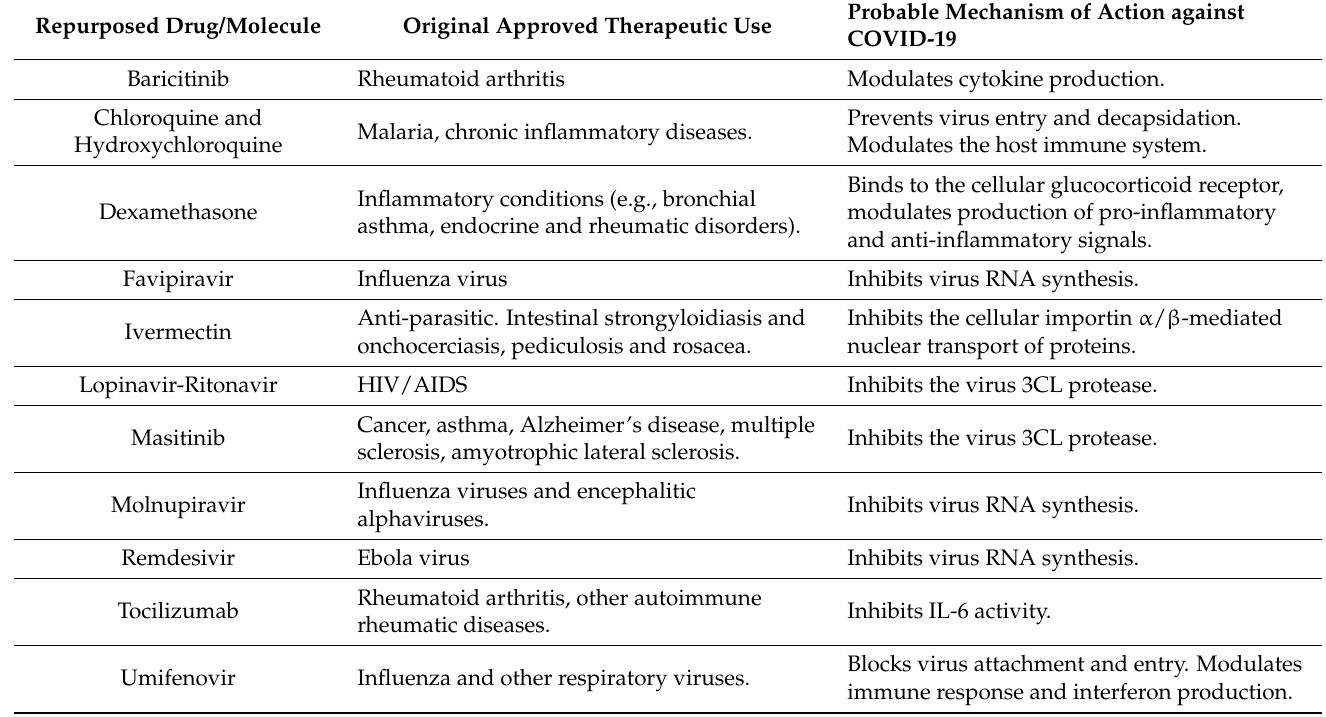
Table 2. Most studied repurposed drugs/molecules for COVID-19